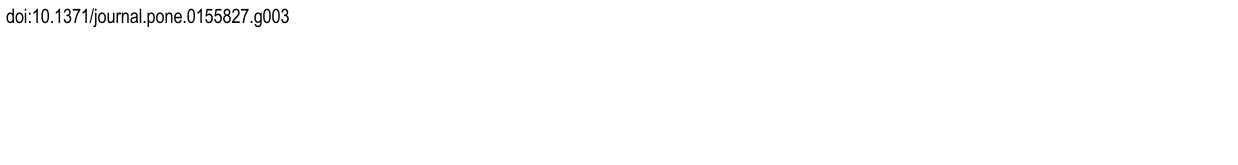
PLOS ONE | DOI:10.1371/journal.pone.0155827 May 19,